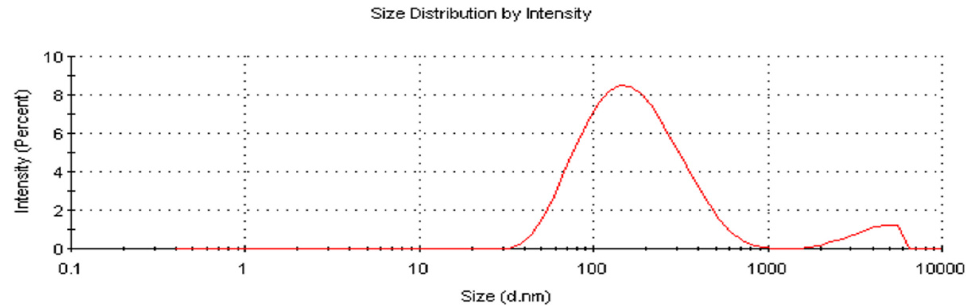
Figure 10. Zeta potential pattern of AC-AgNPs. 2.8. Antimicrobial Activity Silver ions produced at the micro level in the aqueous media are primarily responsible for AgNPs’ antibacterial capabilities [56]. One of the possible scenarios where plant-mediated AgNPs with ultrasmall sizes and large surface areas suppress the activities and proliferation of microorganisms is that AgNPs bind to negatively charged cell surfaces and change the physical and chemical properties of the cell membrane and wall, thereby weakening the basic functions of the cell such as permeability, electron transport, osmoregulation, and respiration. The second is that AgNPs prevent the formation of the organism by interacting with DNA, proteins, and cell components containing sulfur/phosphorus [55,56]. Salomoni et al. [56] confirmed that AgNPs bind to bacterial DNA and subsequently attach to bacterial ribosomes, where they inhibit DNA replication and induce bacterial death. The most constant theme of an antibacterial investigation is the relationship between positively charged ions on Ag nanoparticles and negatively charged bacteria, which may also kill the bacterium [9]. AC-AgNPs suppressed yeast and bacterial growth more effectively than AgNO 3 (except E. coli ) and antibiotics (Table 1). When compared to the standard antibiotics, biogenic AC-AgNPs had the strongest inhibitory effect against B. subtilis (0.0625 µg/mL) and S. aureus (0.125 µg/mL). Table 1. MIC values (µg/mL) of AC-AgNPs, AgNO 3 solution, and standard antibiotics. Pathogenes